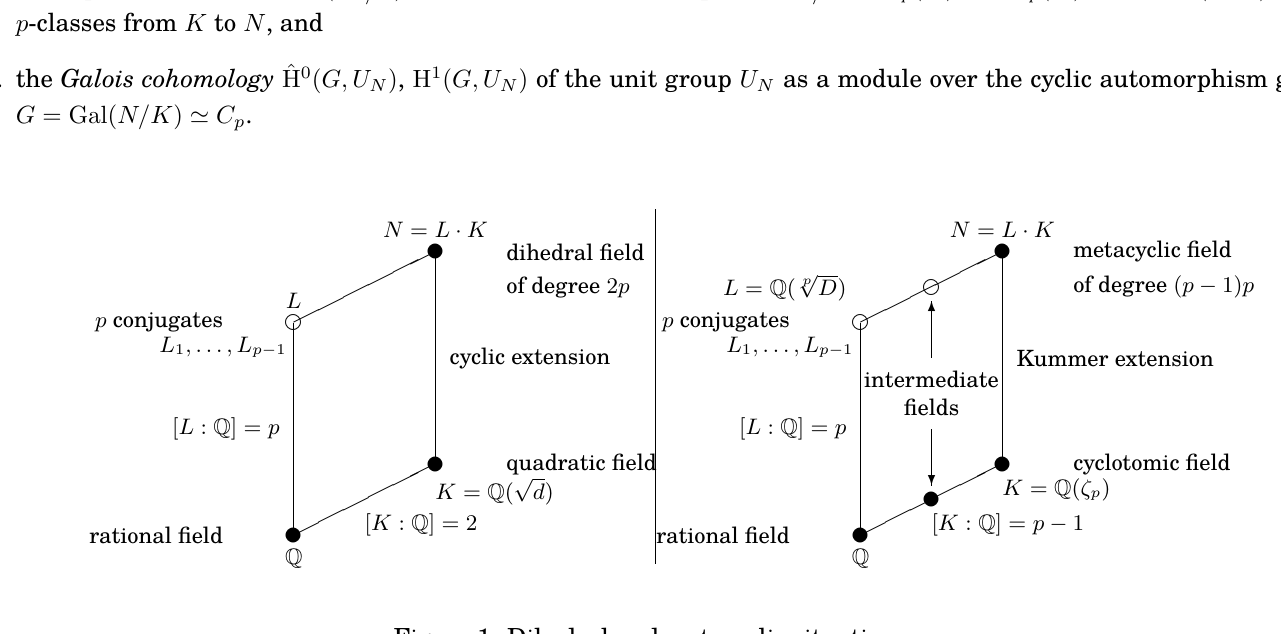
Figure 1: Dihedral and metacyclic